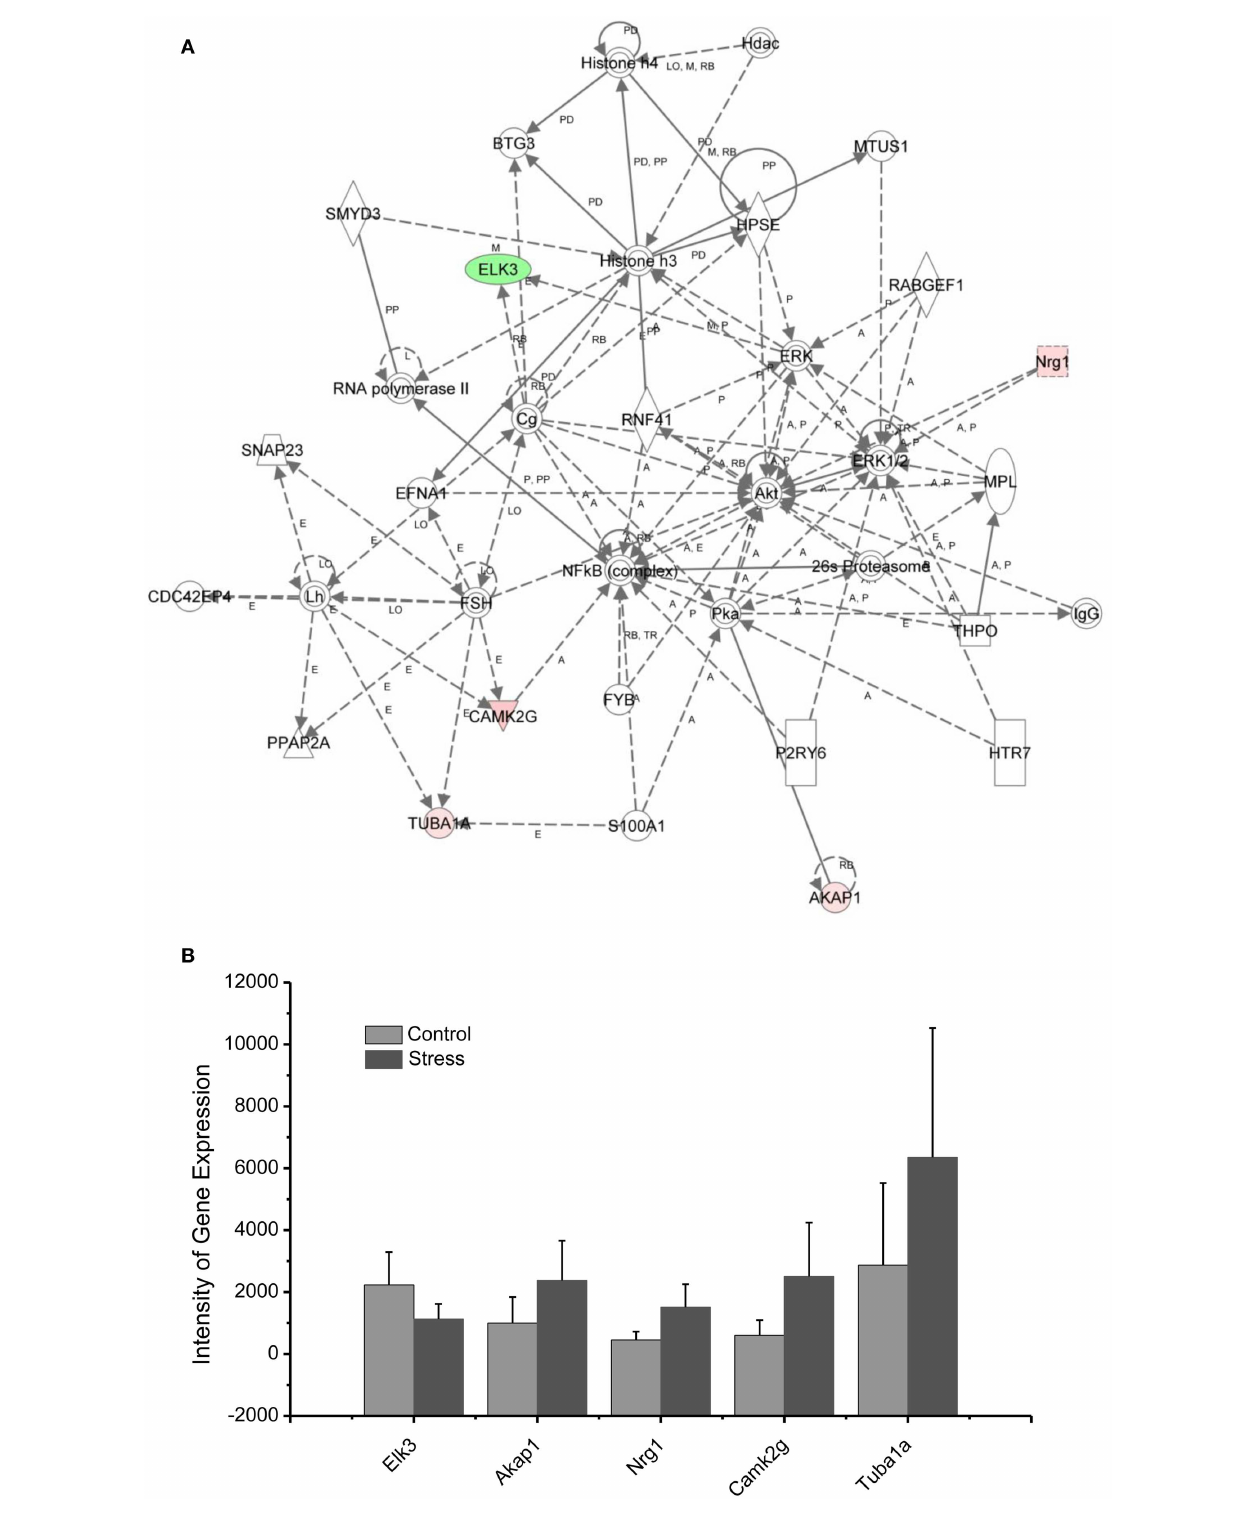
( p < 0.01, n = 10) in the network associated with NFkb, AKt, and Histone 3 in the amygdala 14days after stress.The order is plotted according to fold change, from downregulated with lowest negative value to upregulated with highest positive